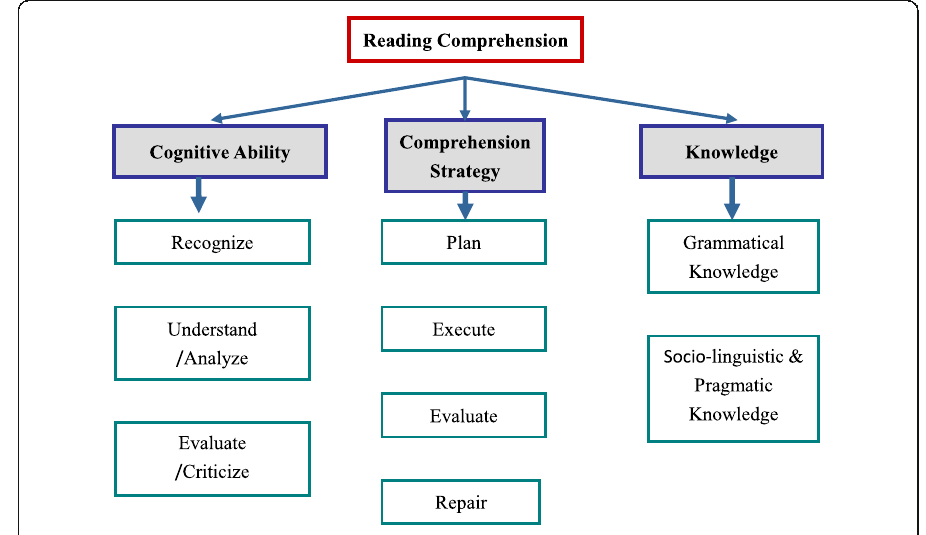
Fig. 2 Framework of the CSE reading